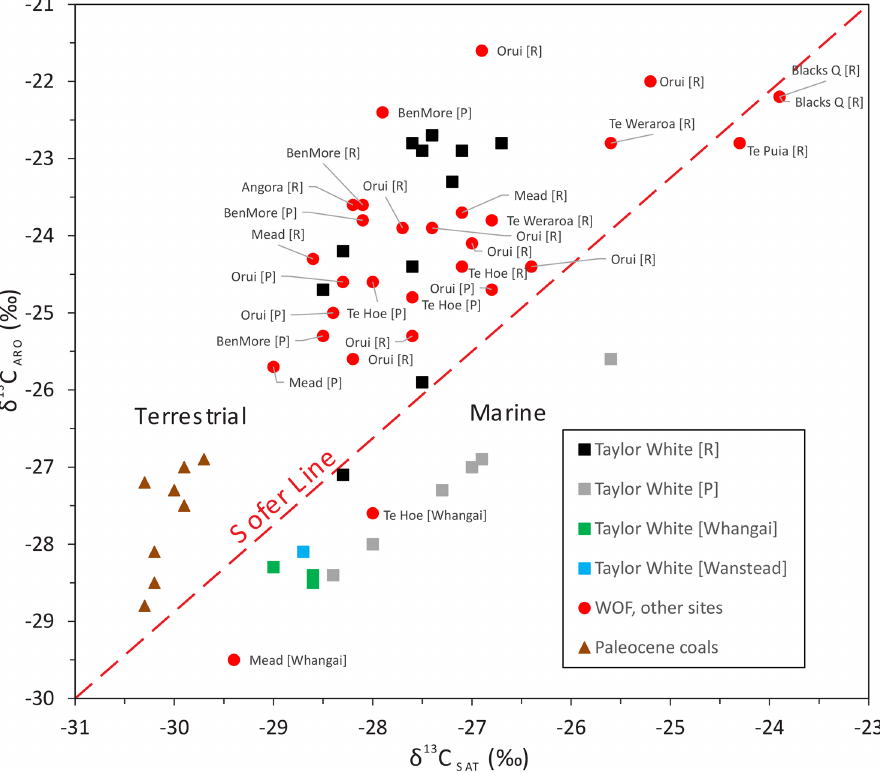
Figure 8. Relationship between δ 13 C values for aromatic (ARO) and saturated (SAT) hydrocarbon fractions for the OM-rich (TOC > 2wt%, [R]) and OM-poor (TOC < 2wt%, [P]) Waipawa organofacies and underlying Whangai facies shown as a cross-plot of the two variables. Samples of Paleocene coaly rocks are included for comparison (see Table S5 for sample details). The Sofer line is used to separate marine and terrestrial OM sources in oils (Sofer,